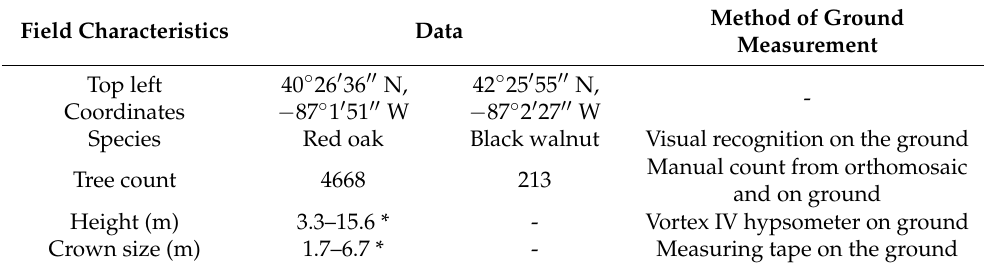
Table 1. Plantation layout characteristics for the study area.